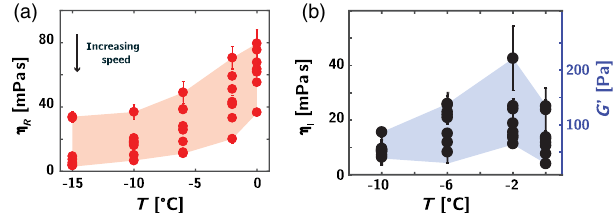
FIG. 4. Temperature effects. (a) Evolution of the real part of the viscosity (dissipation) as a function of temperature: we observe a steady increase toward the melting point, reminiscent of the friction force trend [see Fig. 1(c)]. (b) Imaginary (elastic) part of the viscosity of the interstitial fluid as a function of temperature. The right-hand axis of (b) provides the corresponding elastic modulus G 0